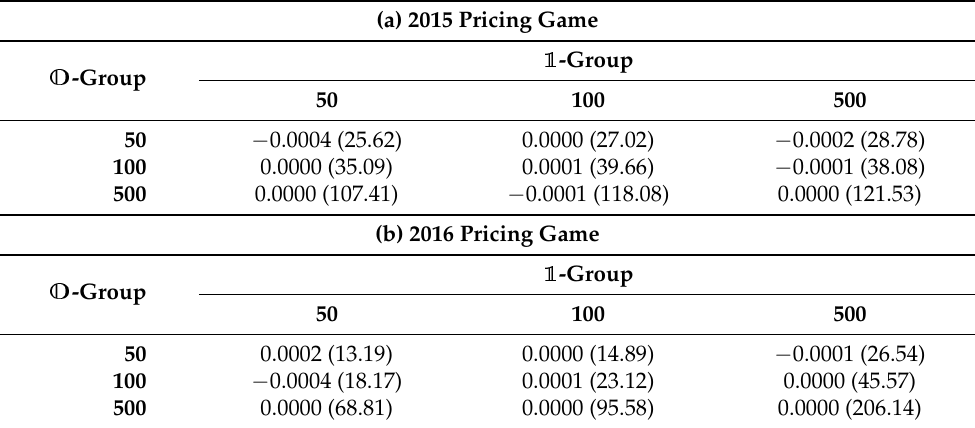
Table A4. Bias and run time (s), the latter between brackets, for the approximation ˆC the 2015 and 2016 pricing game dataset. This is given for the rough grid approach and for several different numbers of clusters for the O - and 1 -group.